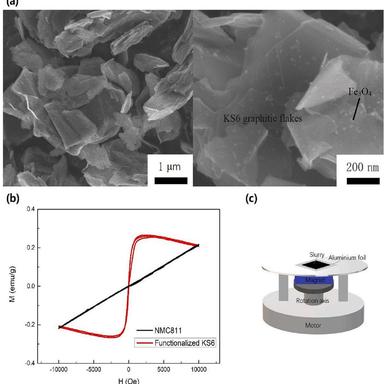
(a) SEM images of functionalized KS6 flakes; (b) Magnetization vs magnetic field of NMC811 microparticles and functionalized KS6 flakes at 300 K; (c) Setup of rotating magnetic field used for casting of electrode slurries followed by magnetic alignment of KS6 flakes.